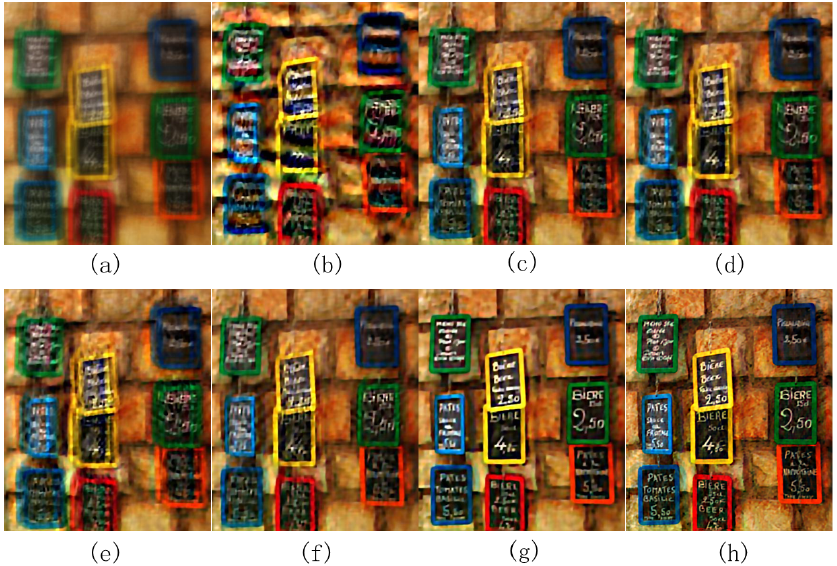
Figure 7. Visual comparison of the results using one challenging image: ( a ) blurry image; ( b – h ) deblur- ring results generated by Ref. [14], Ref. [6], Ref. [52], Ref. [48], Ref. [19], Ref. [18] and our method, respectively. The recovered image by the proposed algorithm is visually more